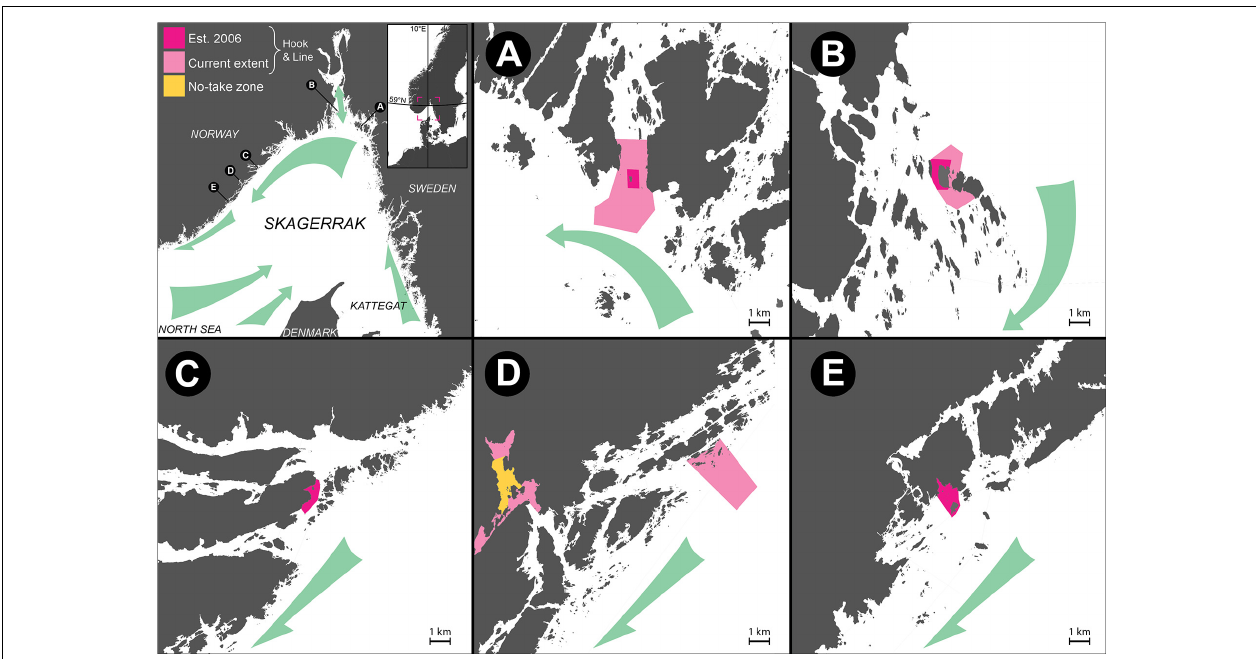
FIGURE 1 | Maps of MPAs in Skagerrak reviewed herein, drawn on equal scale, presented in sequence according to position along the Norwegian Coastal Current: (A) Kvernskjær, (B) Bolaerne, (C) Risør, (D) Tvedestrand, (E) Flødevigen. Colored squares in upper left corner represent an area equivalent to 1 km 2 in maps (A–E) . Dark pink polygons represent the MPAs established in 2006 (e.g., in A–C,E ); areas expanded or implemented at later dates ( Table 1 ) are in light pink, while the no-take zone is shown in yellow. Prevailing ocean currents and implied larval drift/gene flow is represented by green arrows. For information on control areas, see the studies listed in Table 2 .